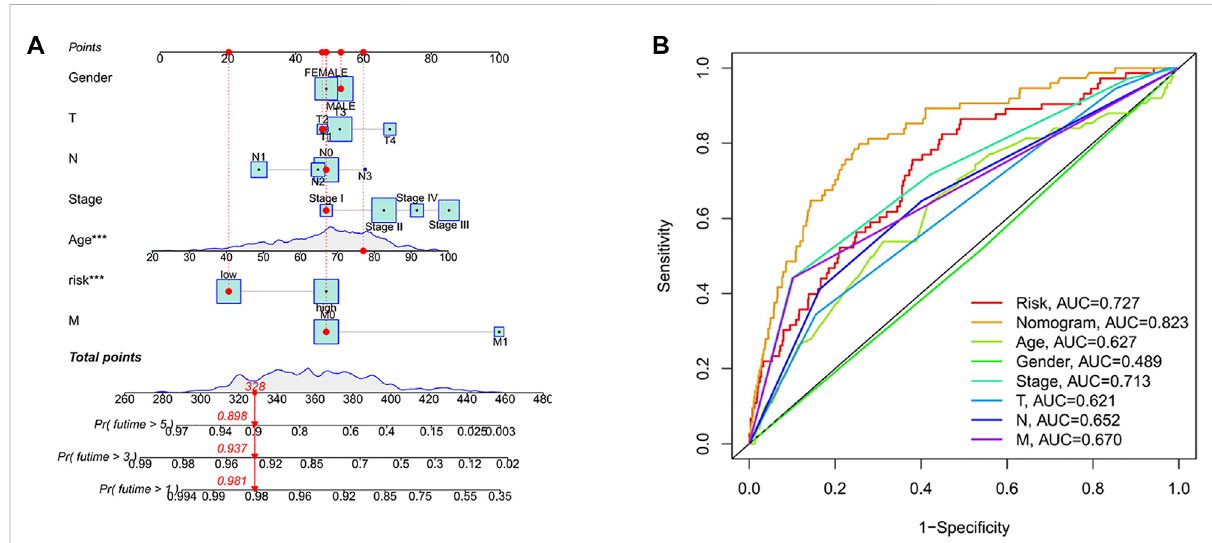
FIGURE 6 DevelopingaNomogram. (A) Nomogram.Whenthetotalpointwas328,thenomogrampredictedthatthe1-yearsurvivalprobabilityofpatients wasmore than 0.981,the3-years survival probability wasmore than0.937, andthe5-yearssurvival probability was more than 0.898. (B) Nomogram ROC curve. The horizontal coordinate represented the false-positive rate expressed by 1-Speci fi city and the vertical coordinate represented the true-positive rate expressed by